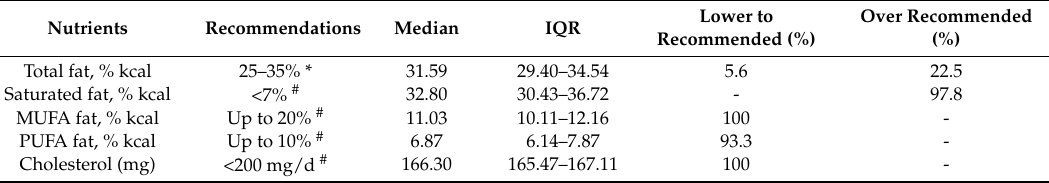
Dietary intake of fat in patients with NAFLD in comparison with NCEP ATP III recommended values.